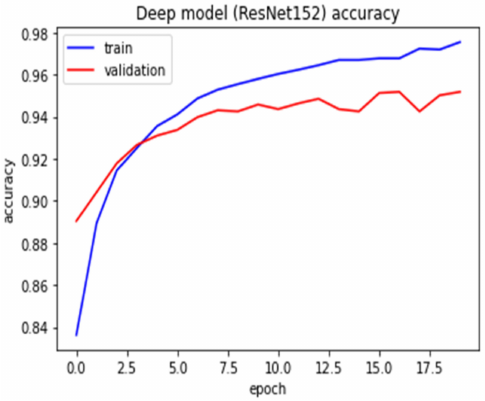
Figure 16. Accuracy curve based on 20 epochs for ResNet152.